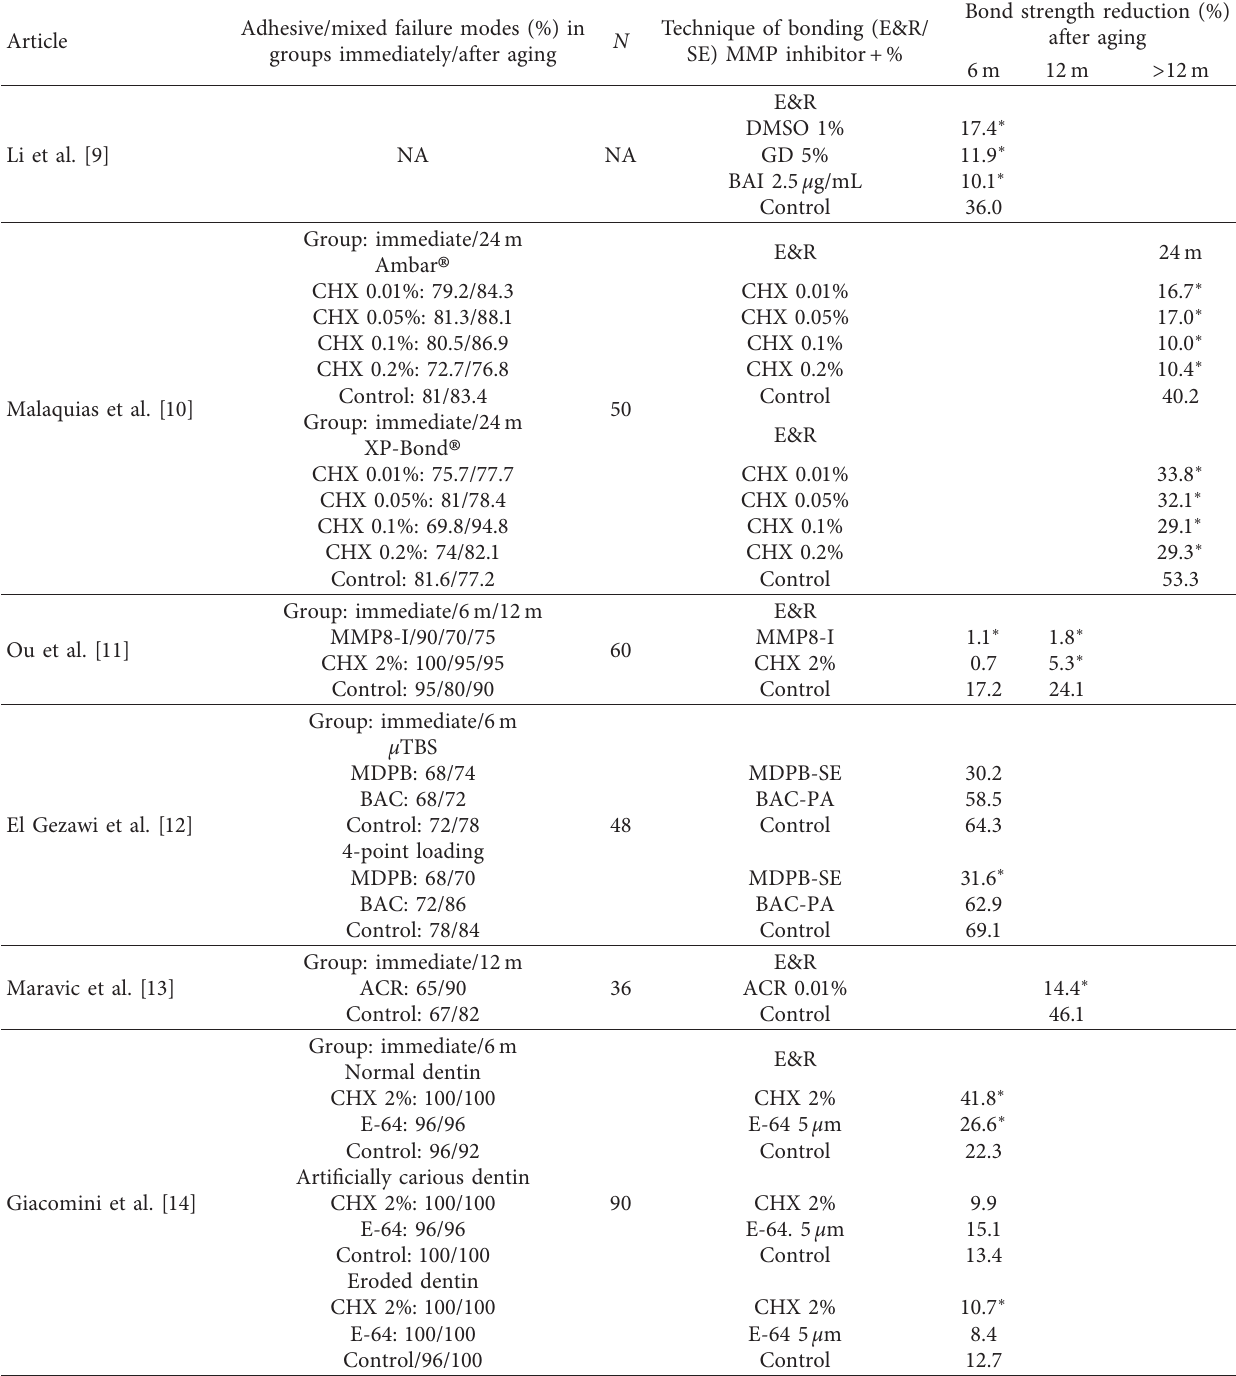
Table 1: Percentages of reduction in bond strength during the follow-up